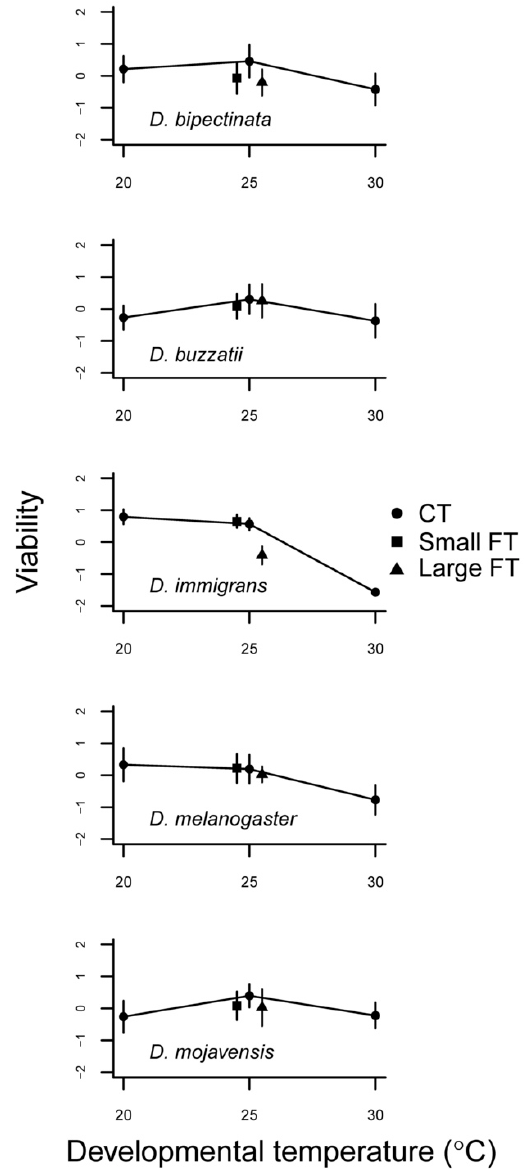
Figure 1. Mean egg-to-adult viability of the combined sexes as a function of developmental temperature regimes in five Drosophila species. Error bars represent 95% confidence intervals. Data were arcsine square root transformed and scaled (see text). CT: Constant developmental temperature; Small FT: Small amplitude fluctuating developmental temperature; Large FT: Large amplitude fluctuating developmental temperature.